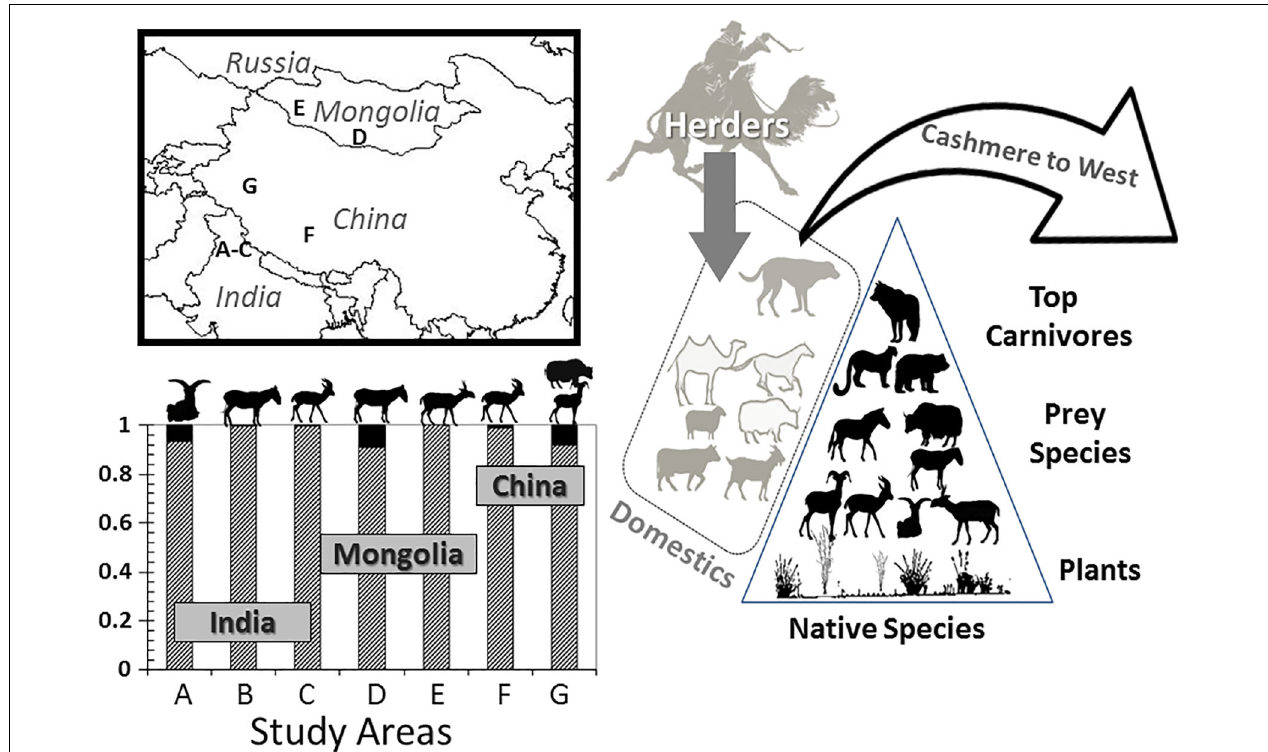
FIGURE 6 | Overview of the components of the cashmere trade to western consumers. Letters–protected areas where native (black bars) and domestic (stippled gray) ungulate biomass is expressed as a proportion of total. Icons from the left to the right are blue sheep, kiang, black-tailed gazelle, khulan, saiga, Przewalski gazelle, argali, and wild yak. The gray icons of domestics (top to bottom) are dogs, camels, horses, sheep, yaks, cattle, and goats. For native species, identified to leave are (top to bottom) wolves, snow leopards, and brown bears [specific study locales listed in Berger et al. (2013)].